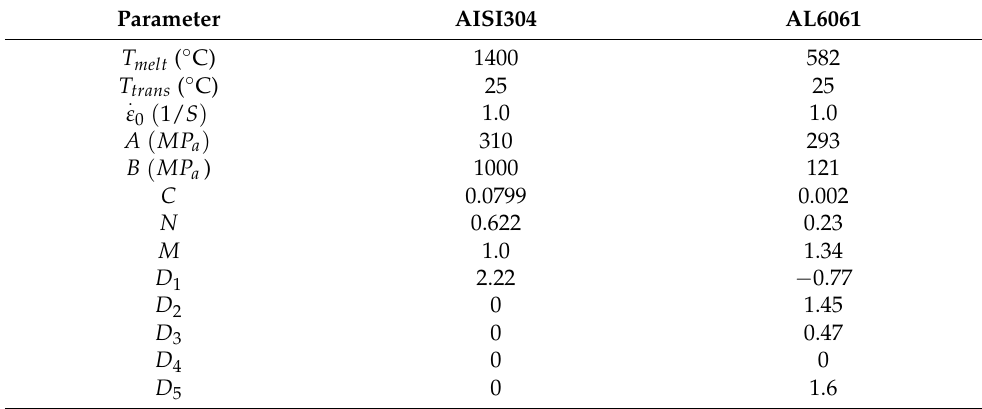
Table 4. Johnson–Cook material damage properties for AISI304 and AL6061